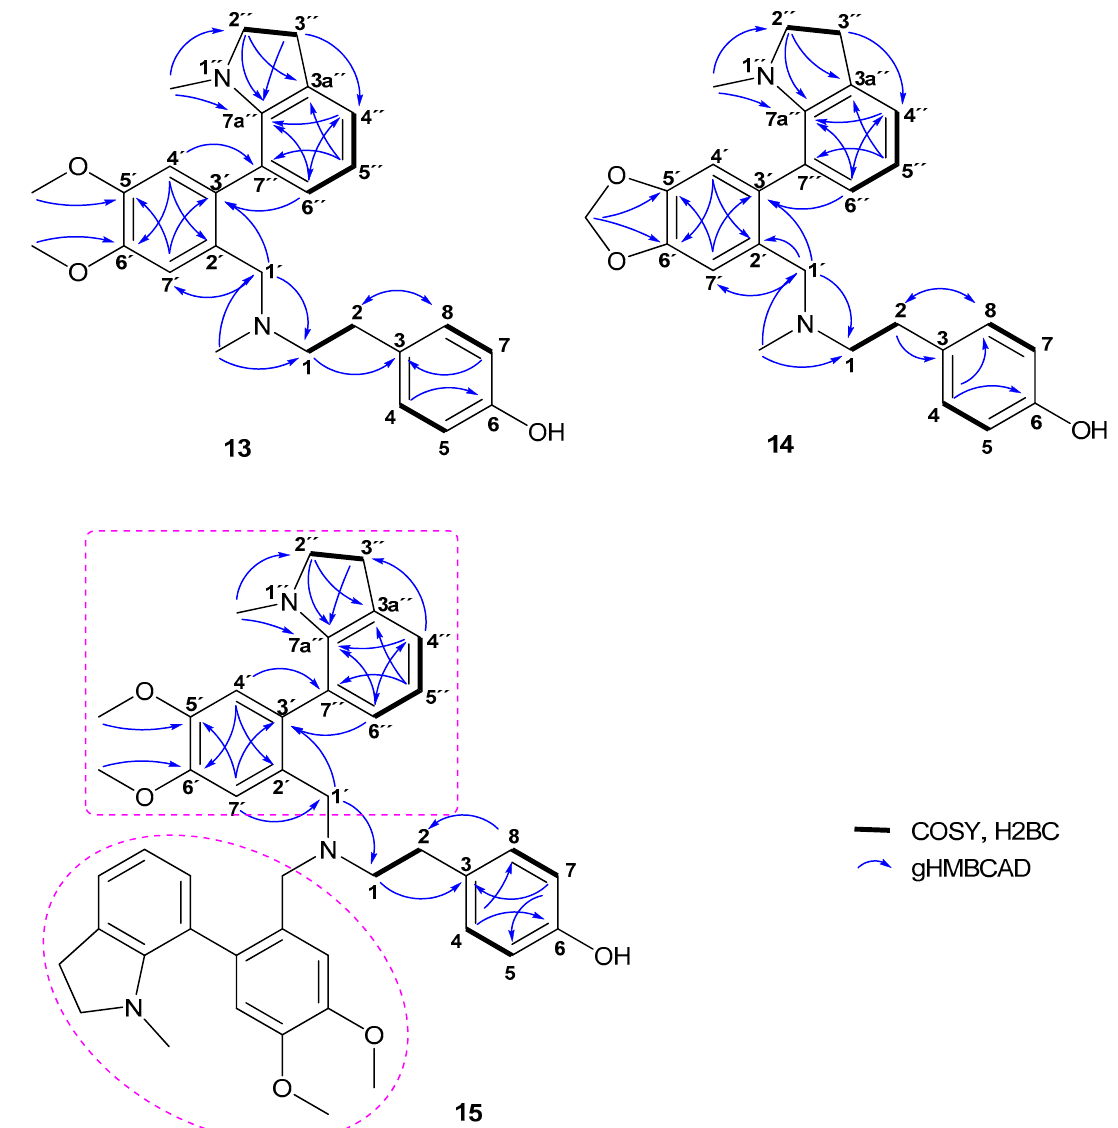
Figure 2. Key 2D NMR correlations of compounds 13 – 15 .